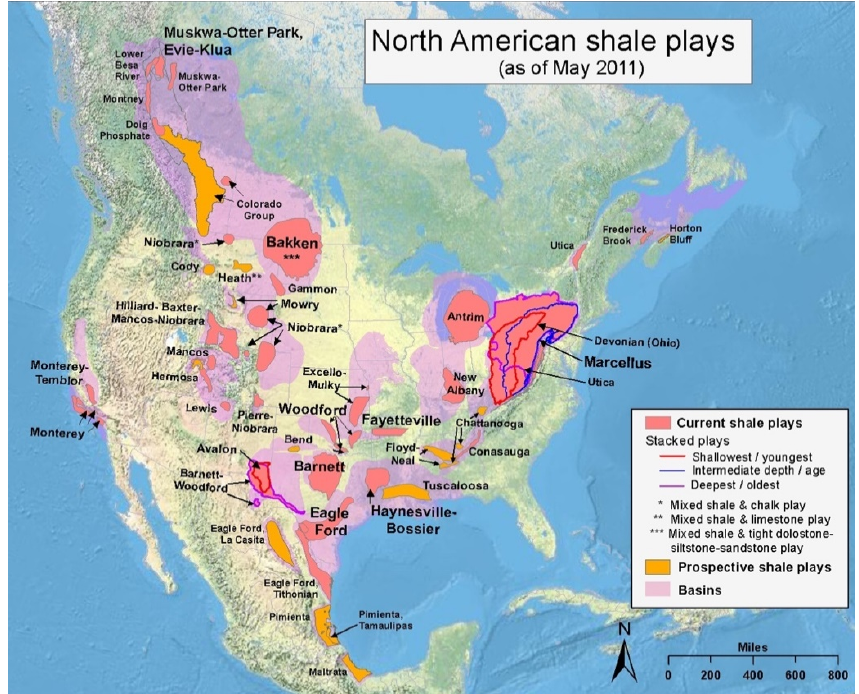
Figure 1. The map of where the samples are retrieved from, showing major shale plays in North America. (Source: USA Energy Information Administration based on data from various studies).